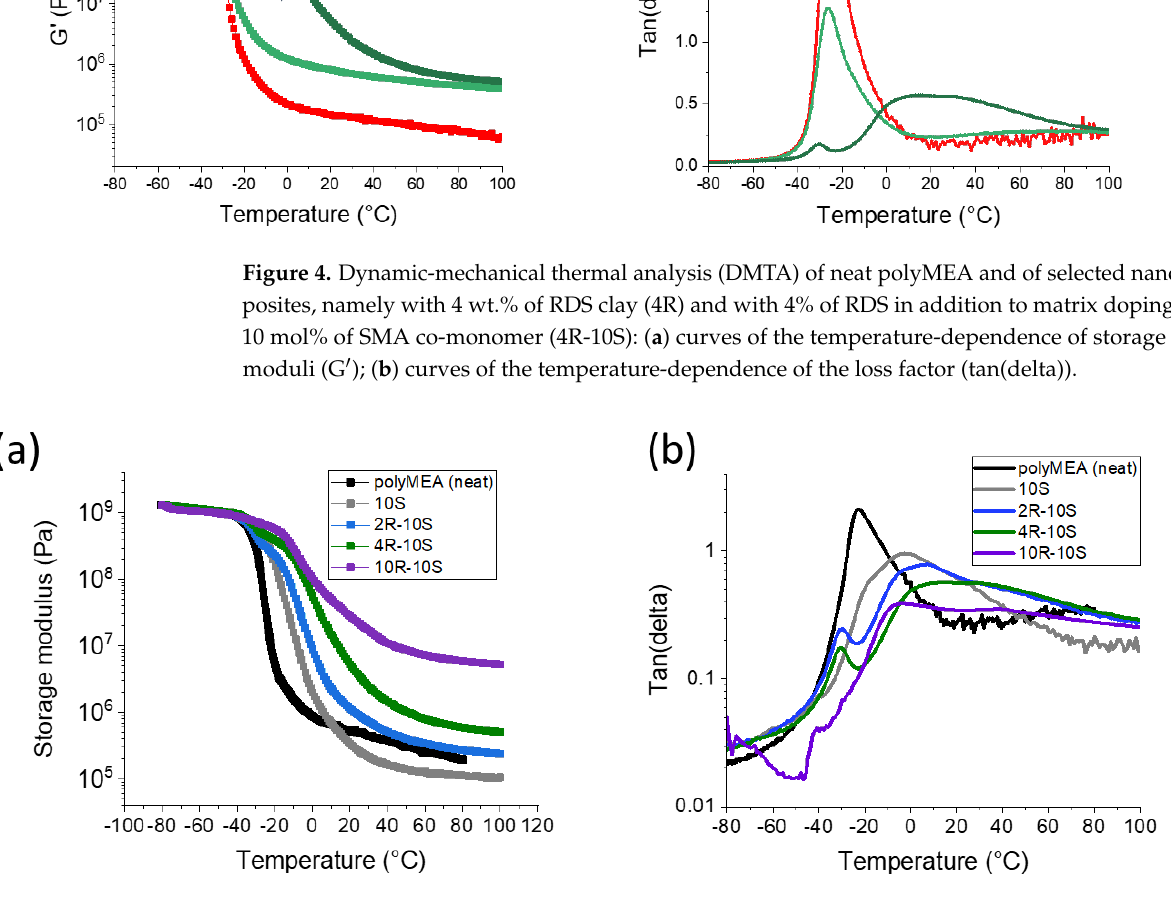
Figure 6. Effect of SMA co-monomer content on thermo-mechanical properties: DMTA analysis of neat polyMEA, as well as of nanocomposites containing 4 wt.% of RDS clay and additionally 1, 5,